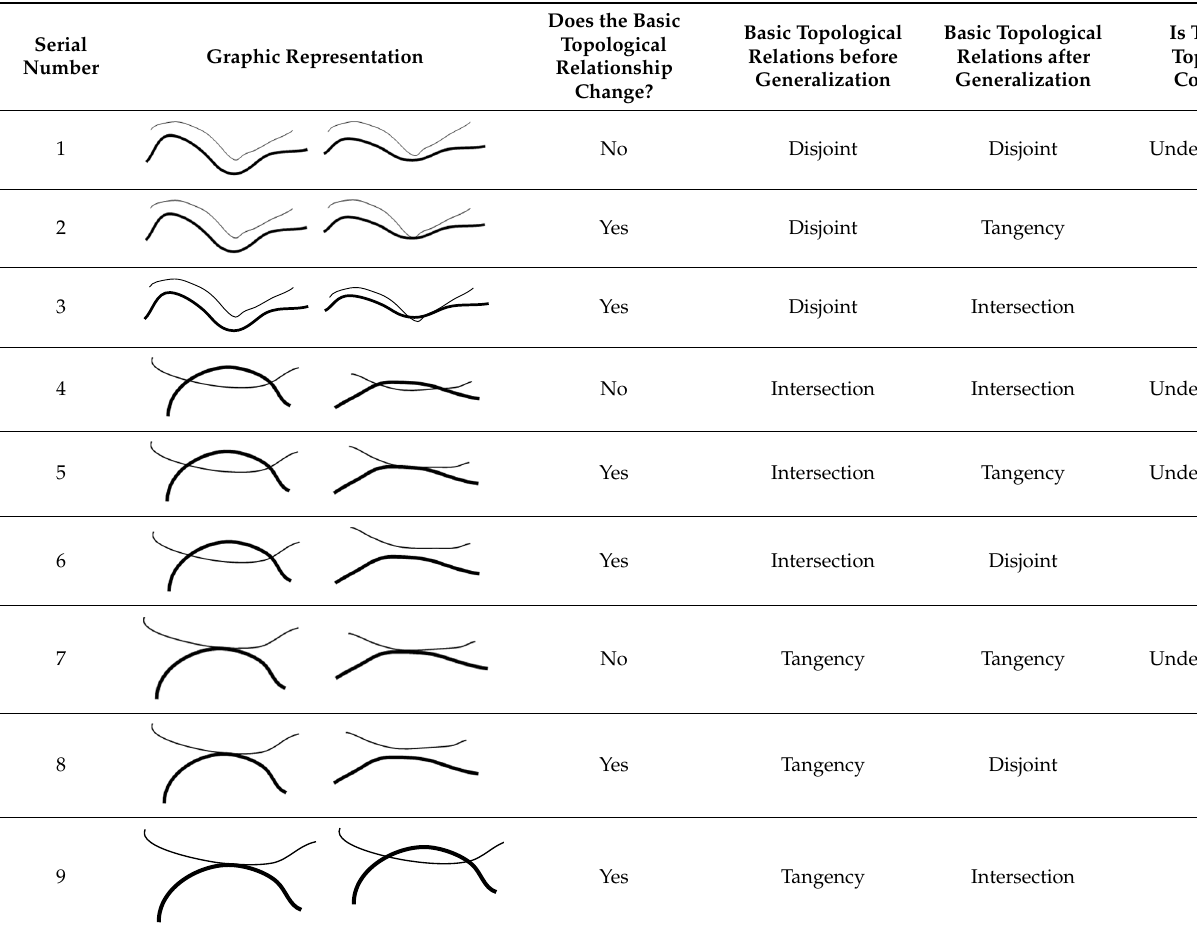
It can be concluded that topology conflict of type II mainly comes from the simplifica- tion and displacement operations from the impact of a single operator on the topological relationship of the road network. In the cartographic generalization of road networks, there are some relations between different operators. Different operators have cooperated to achieve the generalization and updating of the road network. No matter how the operators are combined, the changes to the road network topology can be summarized into nine cases as shown in Table 2. Generally speaking, nine cases can be divided into two types. One is that the basic type of topology relationship remains unchanged. For example, the disjointed relationship is still the disjointed relationship after the update. The other one is that the basic relationship of topology has changed. For example, the intersection relationship changed into the disjointed